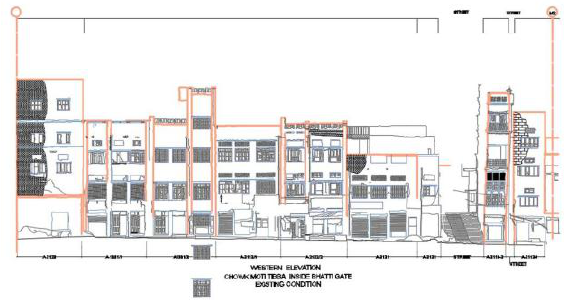
Figure 12. Elevation of urban area digitised through laser scan